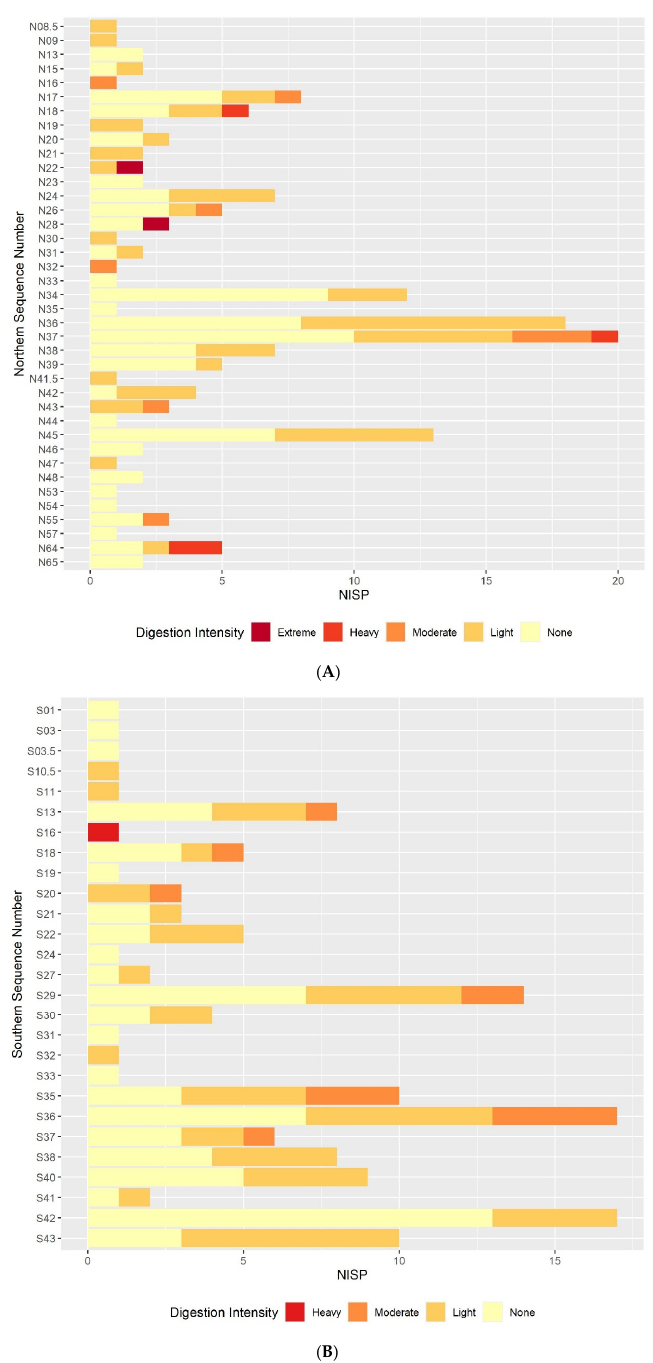
Figure 3. Observed femora digestion intensity in the northern ( A ) and southern ( B ) sequence. NISP: number of identifiable specimens.